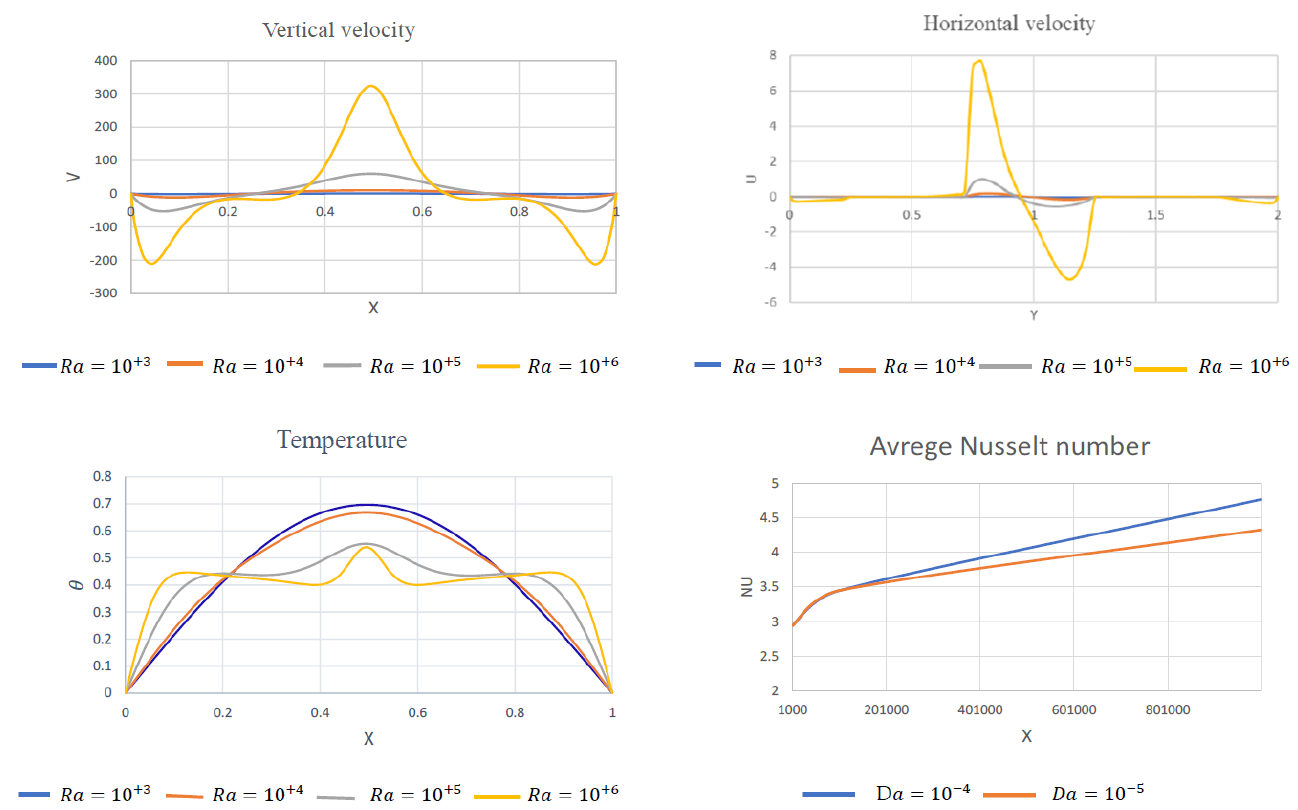
Figure 6. The horizontal and vertical velocities, temperature below the influences of Ra , and mean Nu below the influences of D a .